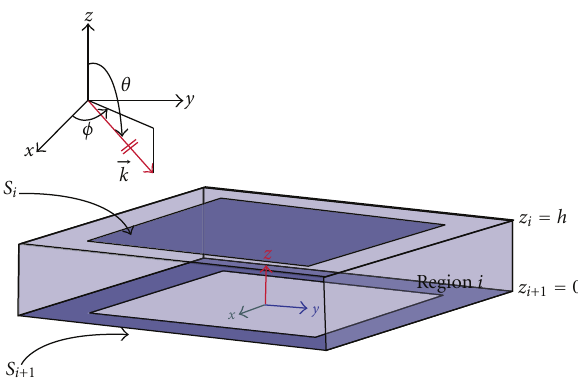
Figure 2: Typical region R i . It is assumed that z i +1 = 0, z i = h .